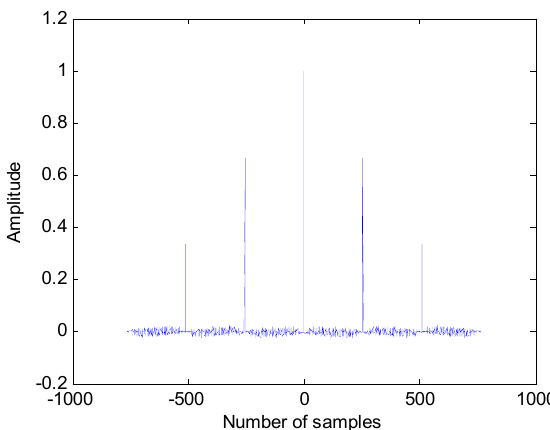
Figure 7. Global autocorrelation function of finite order cyclic m-sequence.